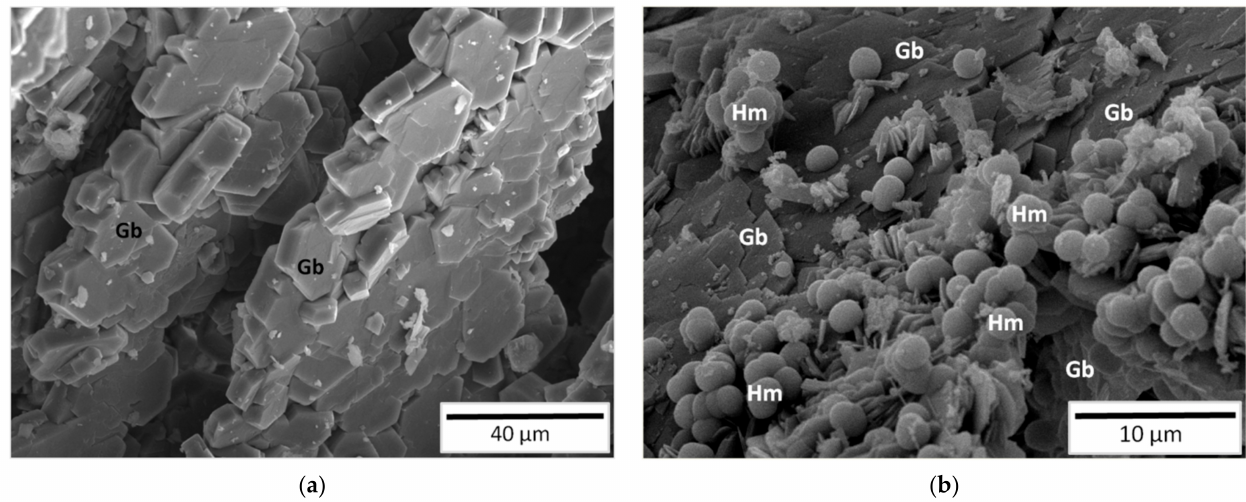
Figure 5. SEM images: gibbsite crystal bimineral film ( a ), gibbsite and hematite crystals ( b ). Gb: gibbsite, Hm: